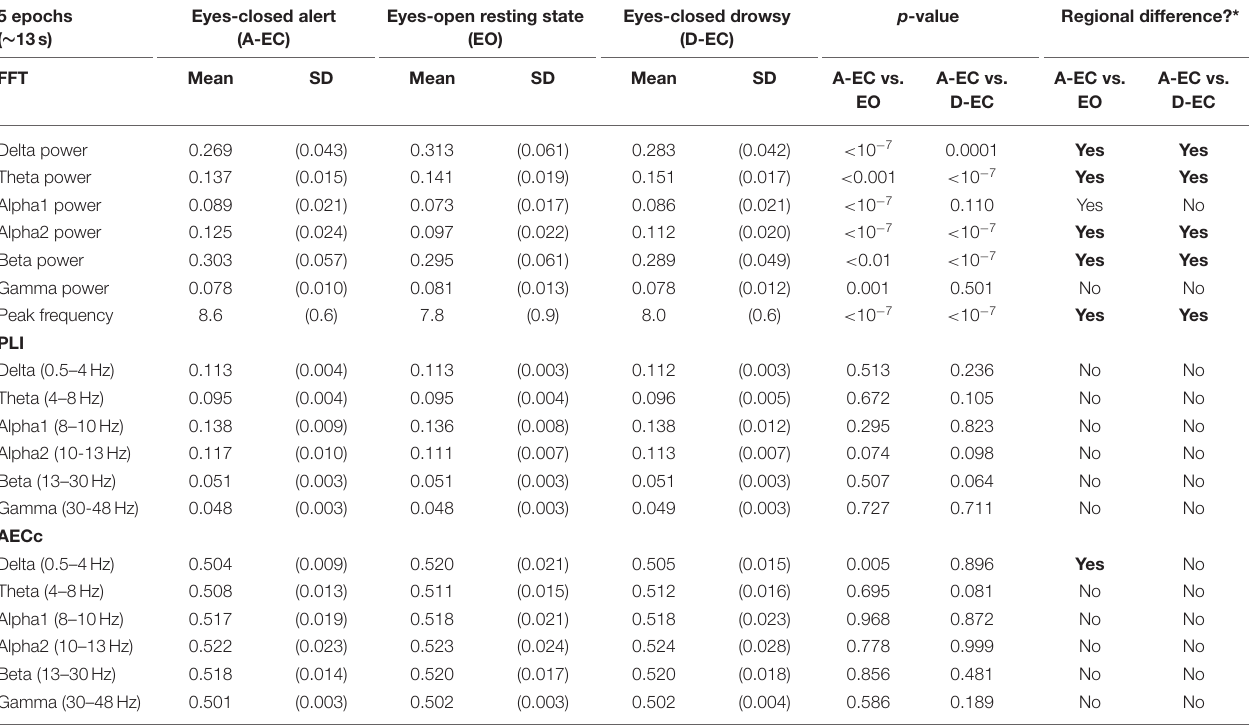
TABLE 1 | Results of spectral and connectivity analyses for the eyes-closed alert (A–EC) and drowsy state (D–EC), and eyes-open (EO) condition. 5 epochs ( ∼